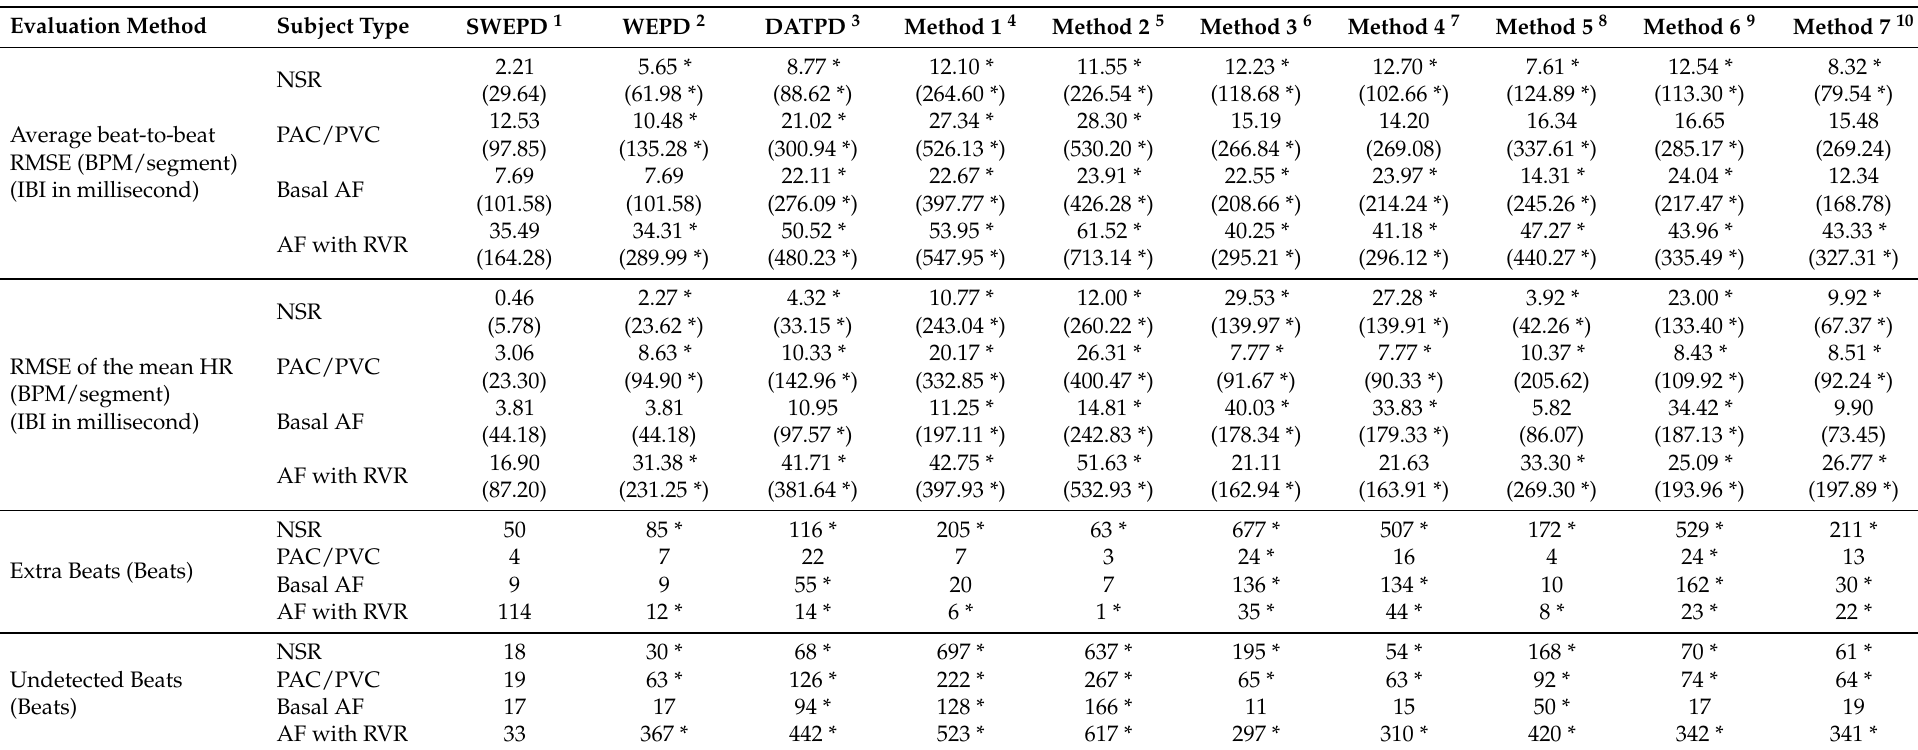
Table 2. Evaluation of Proposed Peak Detection Methods on Training Dataset (Samsung